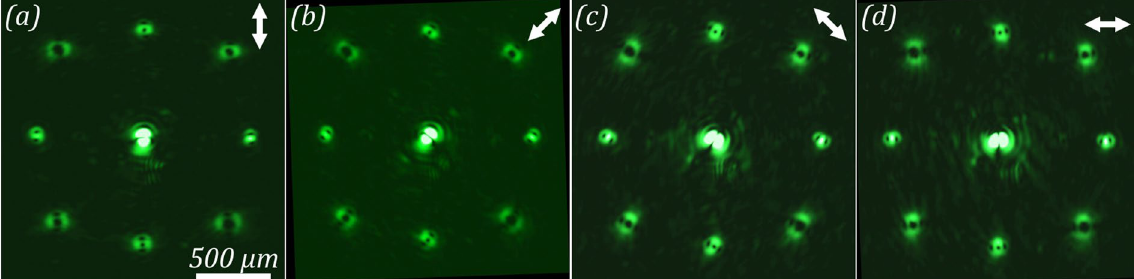
Figure 7. Diffraction pattern formed in the far-field region when passing the laser beam through the amplitude diffractive optical element, generating a superposition of eight vortex beams for different orientations of the analyser. ( a ) 0, ( b ) + 45, ( c ) − 45, and ( d ) 90 degrees.